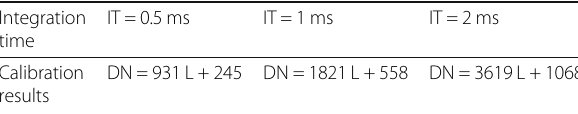
Table 2 Calibration results of FLIR mid-wave infrared camera Integration IT = 0.5 ms time Calibration results